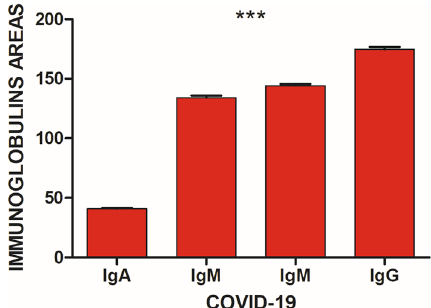
Figure 4. Immunoglobins expression in COVID-19 group (N = 255). IgA (1285–1237 cm −1 ), IgM (1160– 1028 cm −1 , 1420–1289 cm −1 ), IgG (1560–1464 cm −1 ). The IgA was the lowest expressed immunoglobulin, and the most expressed was de IgG, showing a statistical significance between each immunoglobulin. Means of immunoglobins expression with error bars representing the standard deviation are depicted, ***p < 0.005, compared between each